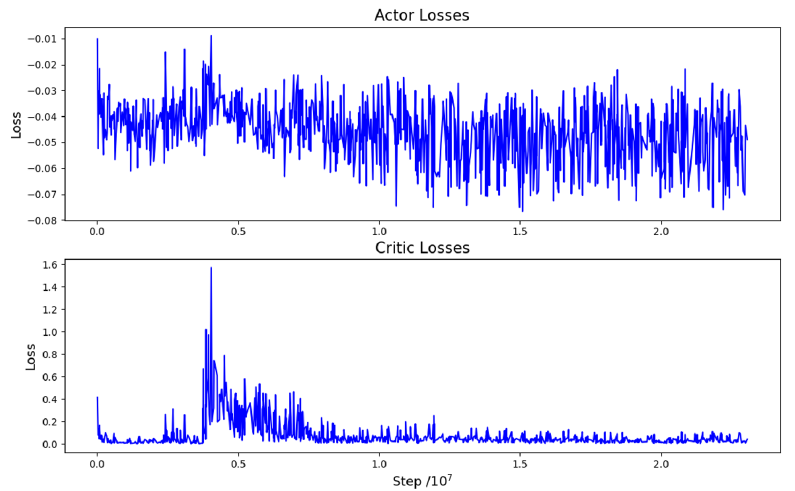
Figure 6. Actor losses and critic losses during the training.